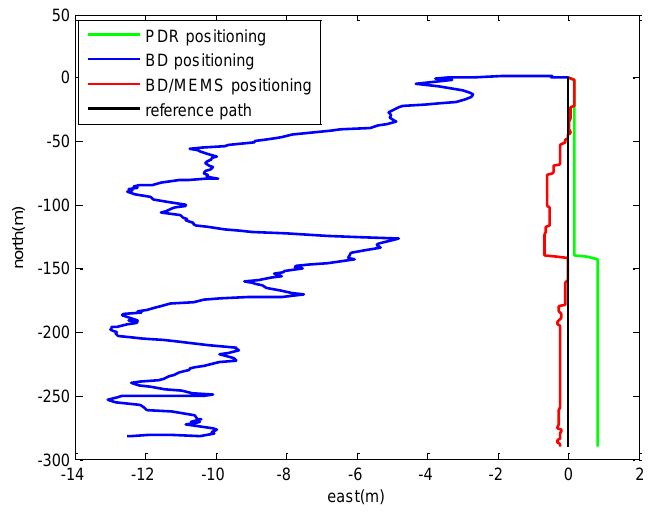
Figure 13. Comparison of